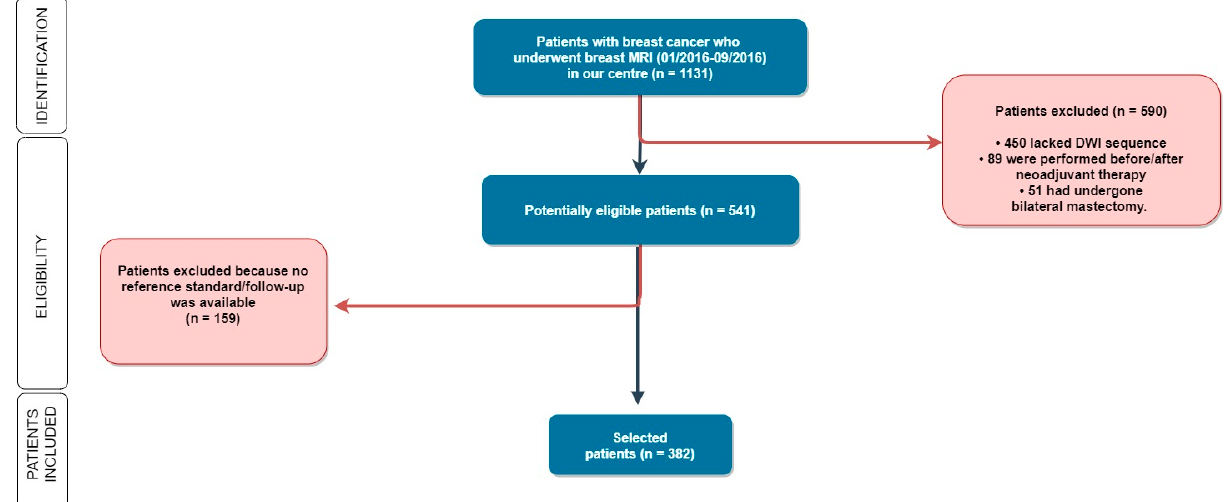
Figure 1. Out of 1131 women enrolled in our study, we selected 382 patients according to our inclusion and exclusion criteria. MRI: Magnetic Resonance Imaging; DWI: Diffusion Weighted Imaging.